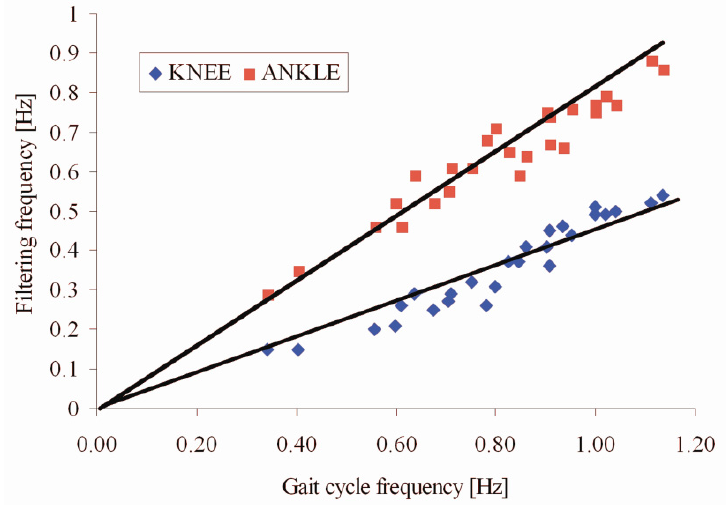
Figure 7. Optimal filtering frequencies for knee and ankle angles versus gait cycle